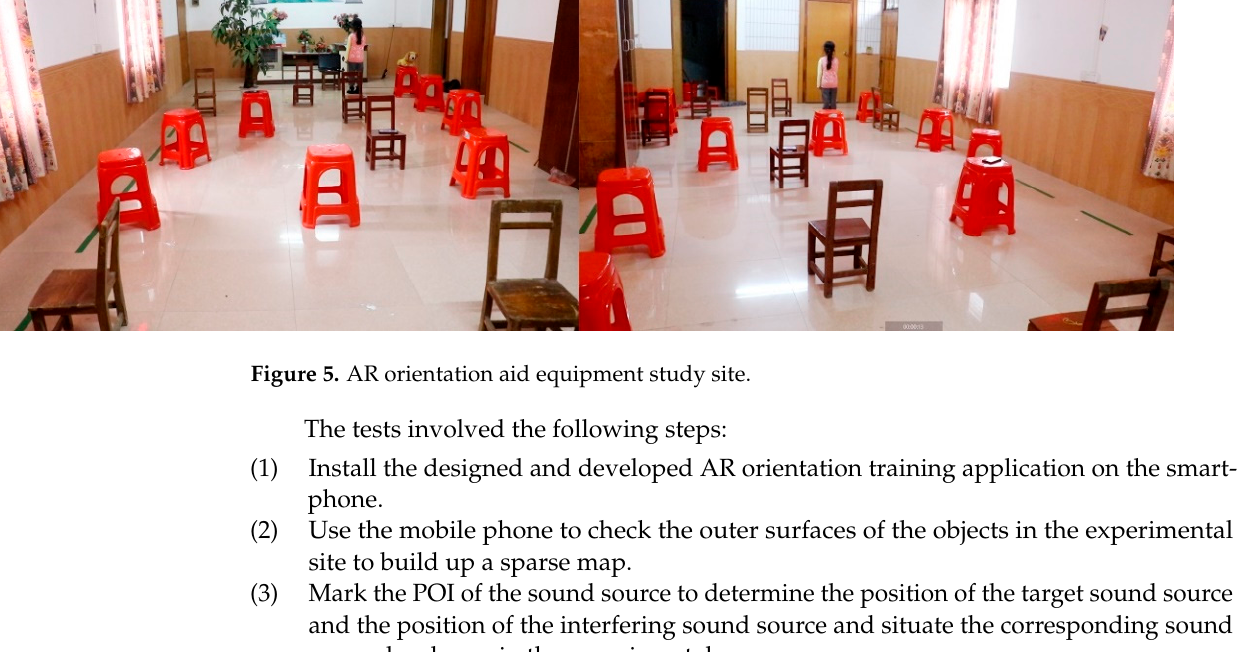
Figure 4. Design concept drawing of orientation aids.